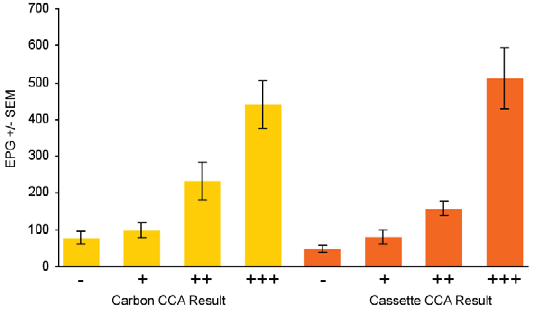
Figure 3. SWAP-ELISA values correlate with level of schisto- some infection. Average SWAP-ELISA values for the negative, light, moderate and heavy intensities of infection as determined by average EPG (p , 0.001, Kruskal-Wallis ANOVA).